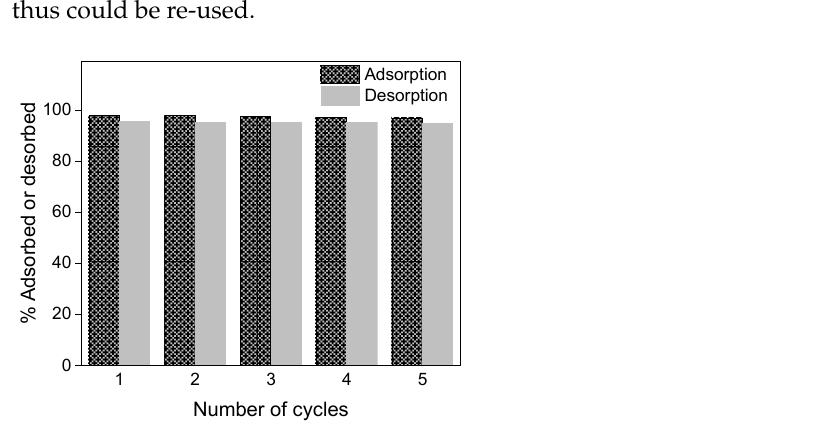
As(V) c / c 0 time, min Figure 6. Breakthrough curve of As(V) adsorption by permethylated β -CD impregnated Amberlite XAD-4 resin . A significant reduction of the overall cost of water treatment process would be achieved by an adsorbent with good adsorption capacity, as well as showing favorable regeneration properties. The successful regeneration of an adsorbent can therefore be con- sidered an essential action for determining the applicability of an adsorbent in water re- mediation practice [50]. The results of regeneration studies indicated that 0.1 M NaOH solution is worthy for this operation in the case of immobilized CD ligand and can be applied as a regenerating factor. The desorption rate was high; when a volume of 60 mL of regeneration solution was passed through column, more than 95% of As(V) ions were desorbed. The stability and potential reusability of the impregnated resin were also evaluated